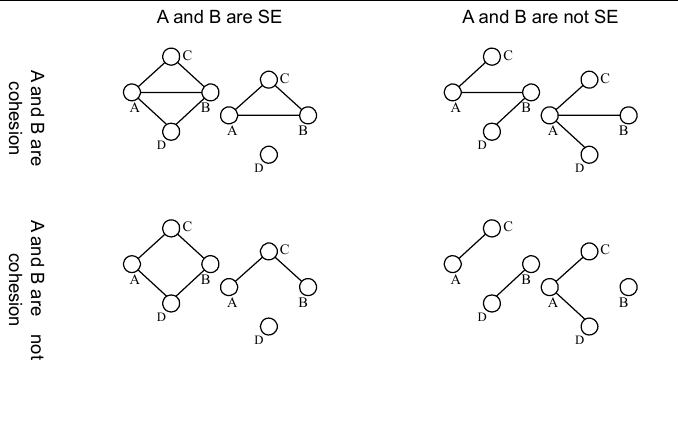
Figure 1. Cohesion and structural equivalence (SE)